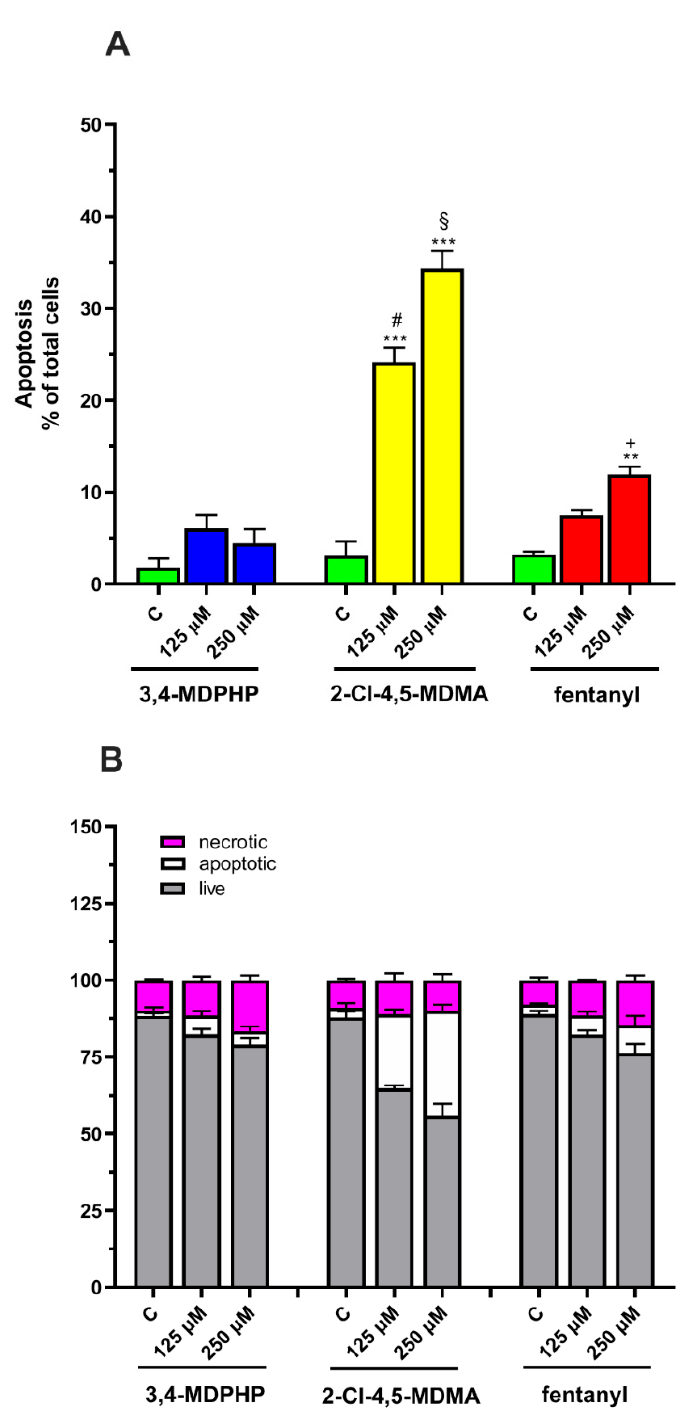
Figure 5. Dopaminergic-differentiated SH-SY5Y cell apoptosis is induced by 2-Cl-4,5-MDMA and fentanyl but not by 3,4-MDPHP. Percentage of apoptosis ( A ) and of live, apoptotic, and necrotic dopaminergic-differentiated SH-SY5Y cells ( B ) after 24 h of treatment with 3,4-MDPHP, 2-Cl-4,5-MDMA, or fentanyl determined by flow cytometry analysis. Data, expressed as % of total cells, represent mean ± SEM from three independent experiments with three replicates for each concentration of the compounds. Two-way ANOVA followed by Tukey’s post-hoc. ** p < 0.01 and *** p < 0.001 compared to their respective controls; # p < 0.001 compared to 125 μ M of 3,4-MDPHP and fentanyl; § p < 0.001 compared to 250 μ M of 3,4-MDPHP and fentanyl; + p < 0.05 compared to 250 μ M of 3,4-MDPHP.